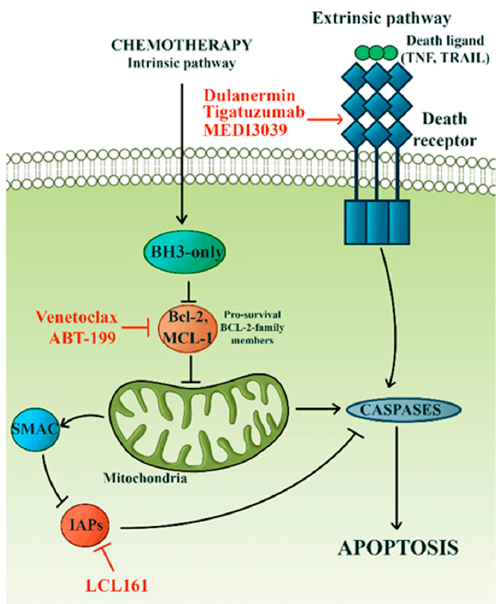
Figure 4. Targeting apoptotic pathways in TNBC. Cancer cells contain two pathways that can trigger apoptosis: intrinsic, that is activated in response to cellular damage, and extrinsic, which is mediated by death receptor activation. Both are potential targets for TNBC treatment.